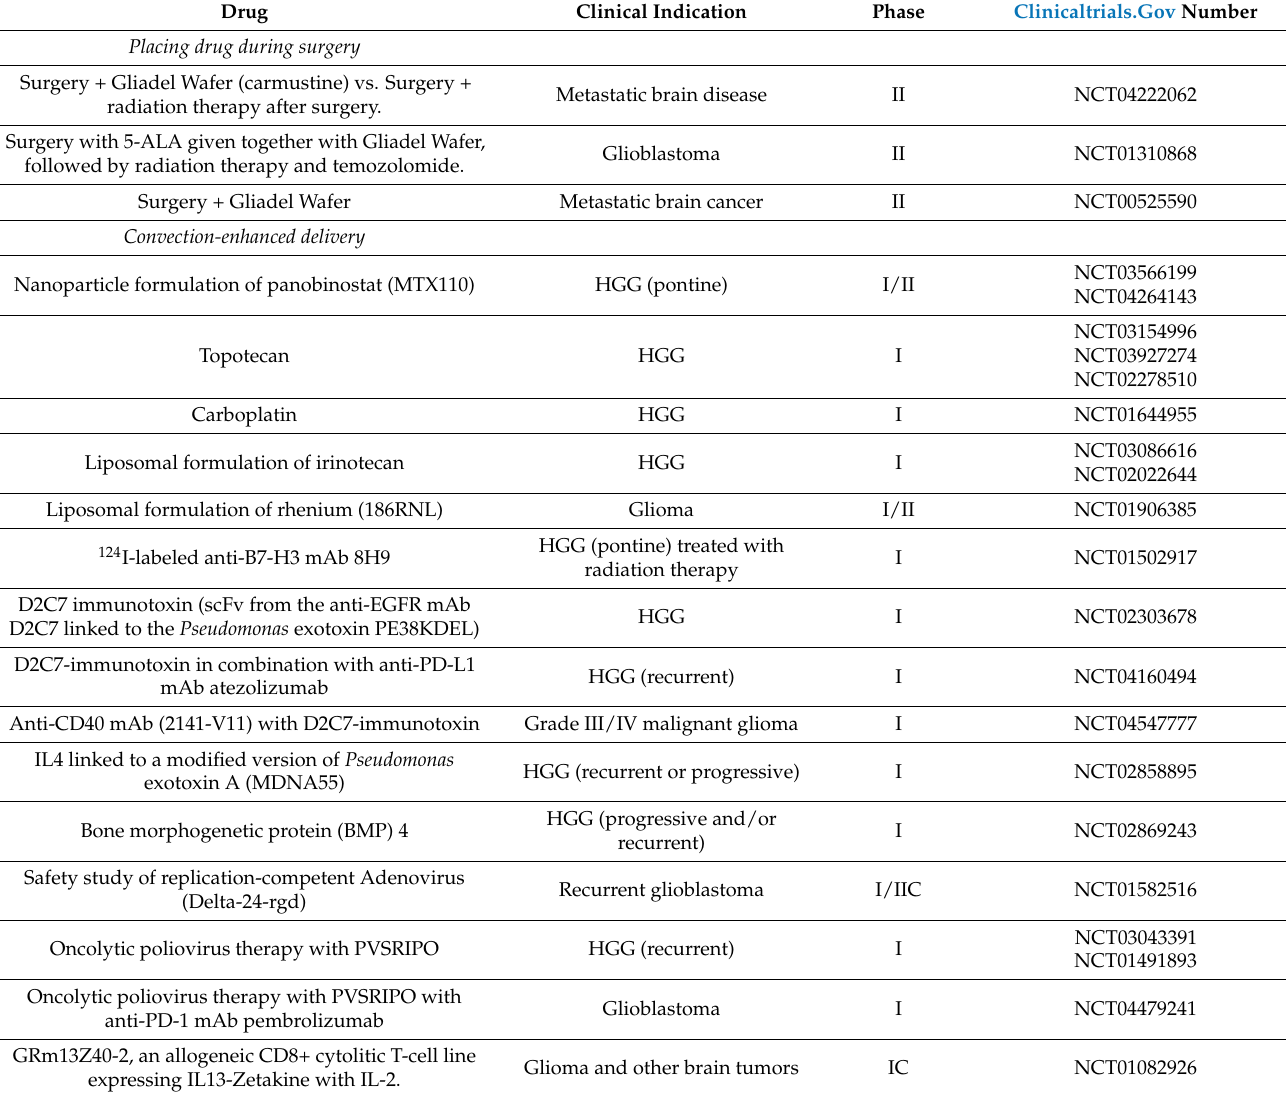
Table 1. Clinical trials with drugs directly delivered into the brain